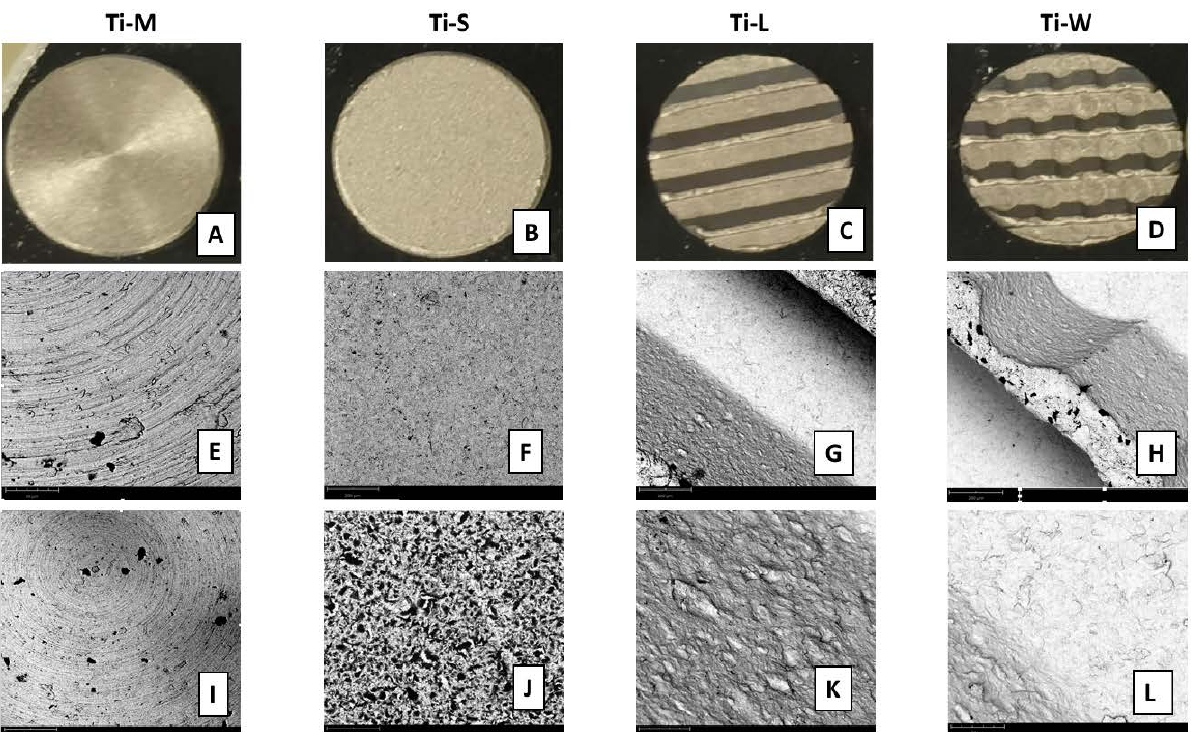
Figure 1. SEM observation of the four types of Ti discs used in the study ( A – D ). SEM morphologies of Ti-surfaces under different magnifications ( E – L ). Topographic macro characteristics were evidenced at low magnification of 290× ( E – H ). Notably, linear and wave macrogeometry of Ti-L and Ti-W substrates ( G , H ). Lower panels: the magnification at 1200× revealed the micro-topographic features of the discs ( I – L ) (scale bar: 200 μm at low magnification, 50 μm at high magnification).